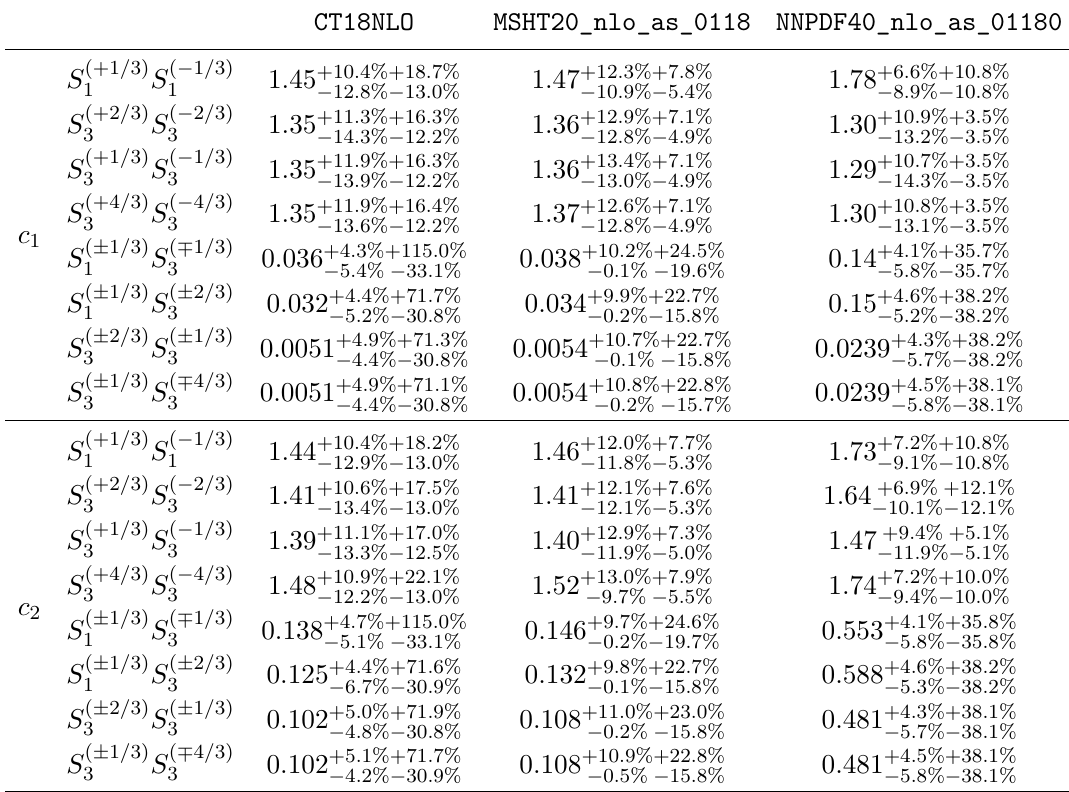
Table 6 . Same as table 4 but for the c 1 and c 2 scenarios of table